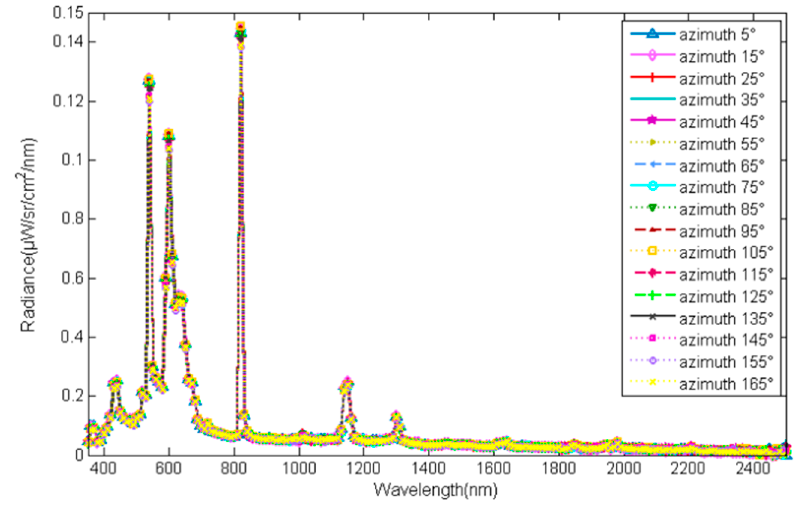
Figure 7. The spectral radiance reflected by the standard target.